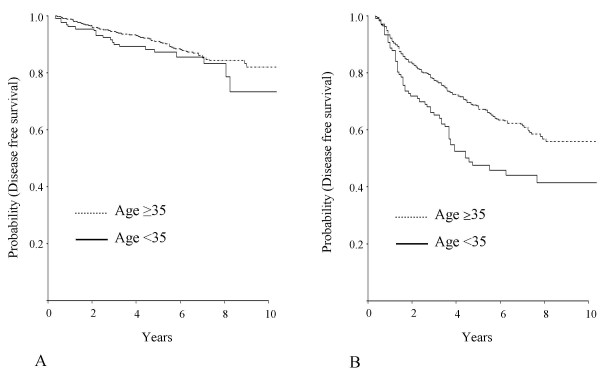
(A) Disease-free survival curves in axillary lymph node-negative patients showing no significant difference between the two age groups (p = 0.223). (B) Disease-free survival curves in axillary lymph node-positive patients showing patients younger than 35 had significantly worse outcomes than their older counterparts (p < 0.001).